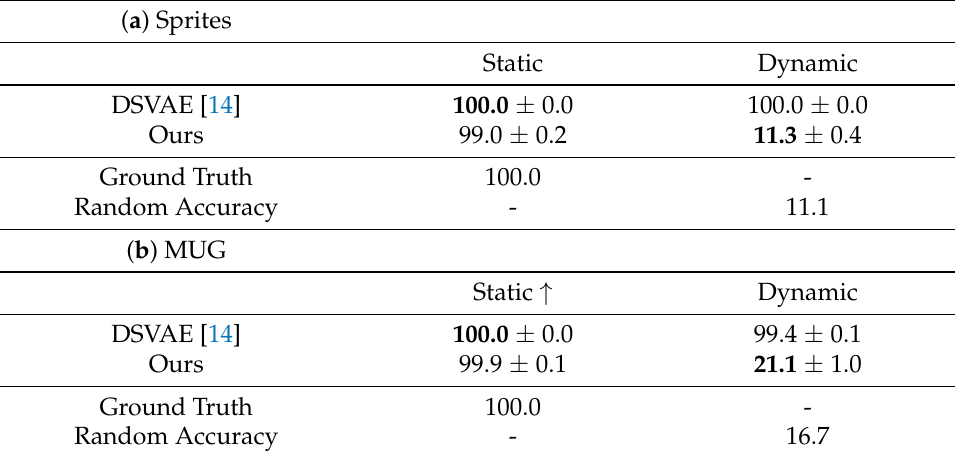
Table 4. Average classification accuracy over ten runs (%) for the fixed static latent variable and randomly sampled dynamic latent variables.